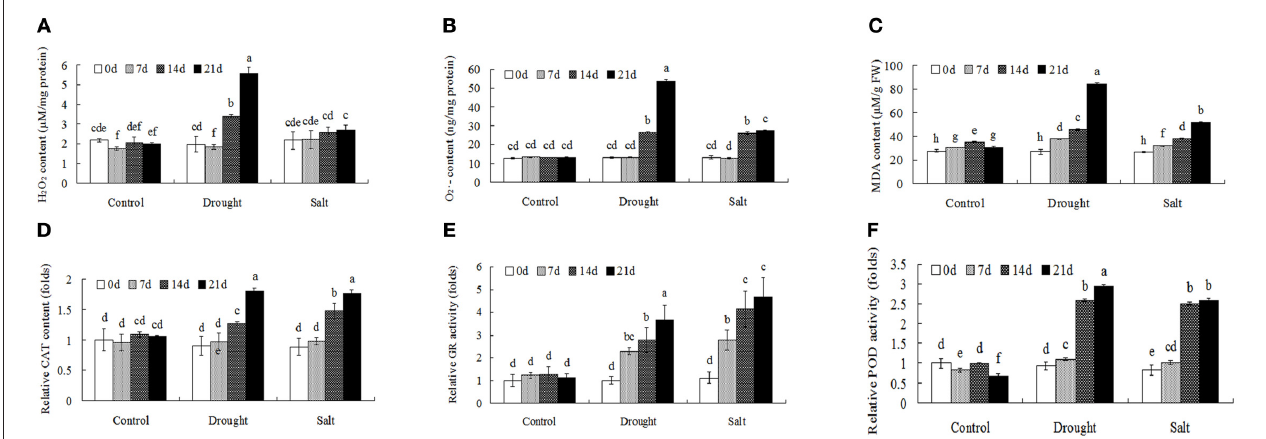
FIGURE 5 | ROS level and antioxidant enzyme activities of bermudagrass under control and stress conditions at designated time intervals. Changes of H 2 O 2 content (A) , O 2 •− content (B) , and MDA level (C) of bermudagrass under control and stress conditions at indicated days. (D–F) Comparisons of CAT (D) , GR (E) , and POD (F) activities of bermudagrass under control and stress conditions at designated time intervals. The relative activities were quantified as fold change in comparison with bermudagrass under unstress condition. The data represent the means of three independent experiment ± SE, and data followed by different letters are significantly different from each other at P < 0.05 according to Duncan’s